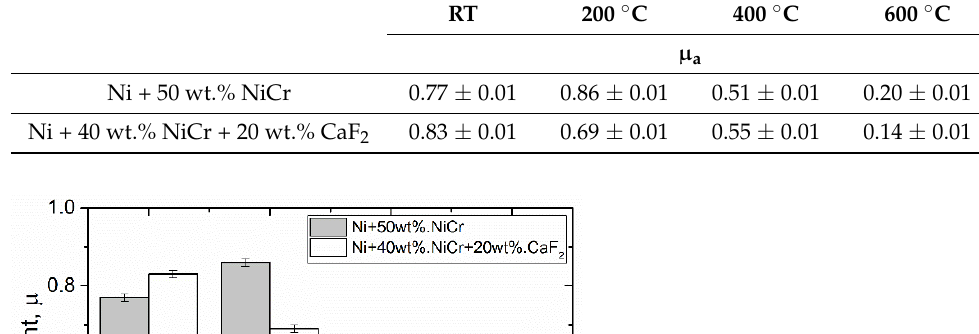
Table 1. Average friction coefficient ( µ a ) of investigated materials.